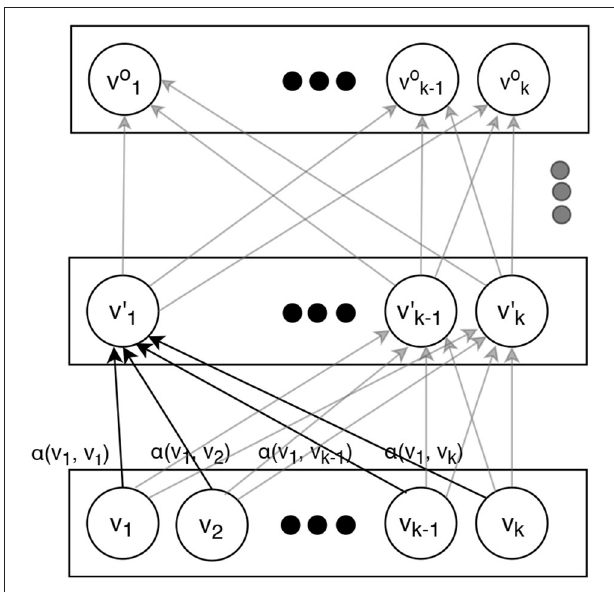
FIGURE 1 | An attention-based transformer used in our experiments.